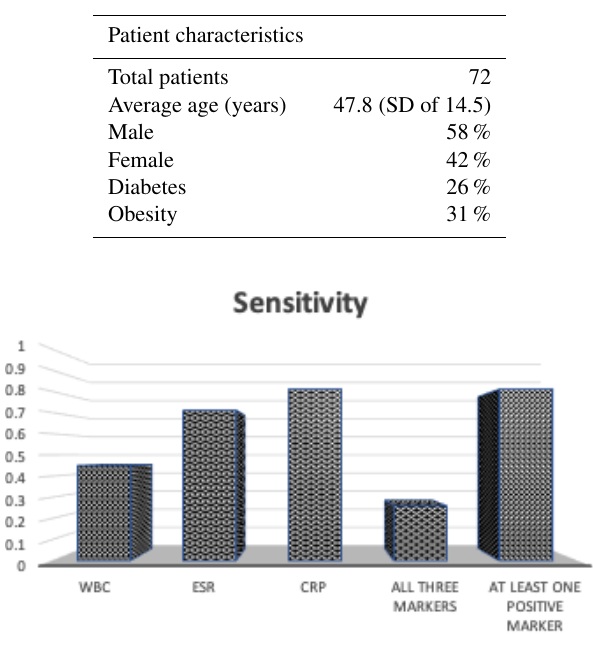
cases. ESR was documented in 53 patients and was elevated